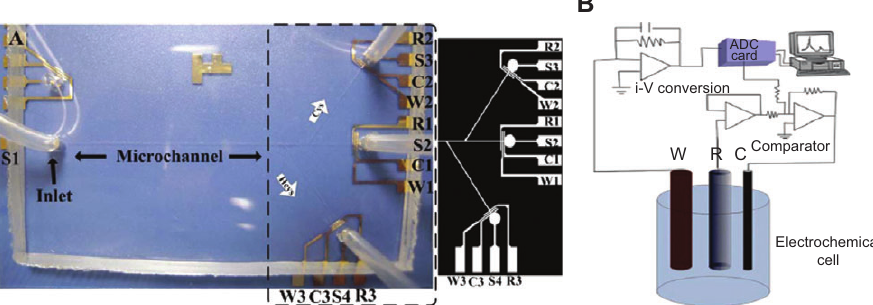
Figure 5 (A) Image of capillary electrophoresis-amperometric detection (CE-AD) microchip showing microchannel engraved in polydi- methylsiloxane (PDMS) mold, sample reservoirs, silicon tubes carrying sample and NaOH solution into the microchannel, gold micro- electrodes (W1-3 = working; C1-3 = counter; R1-3 = reference; S1-4 = separation electrodes); and (B) schematics for electronic circuit and the operation of the in-house built dual potentiostat.